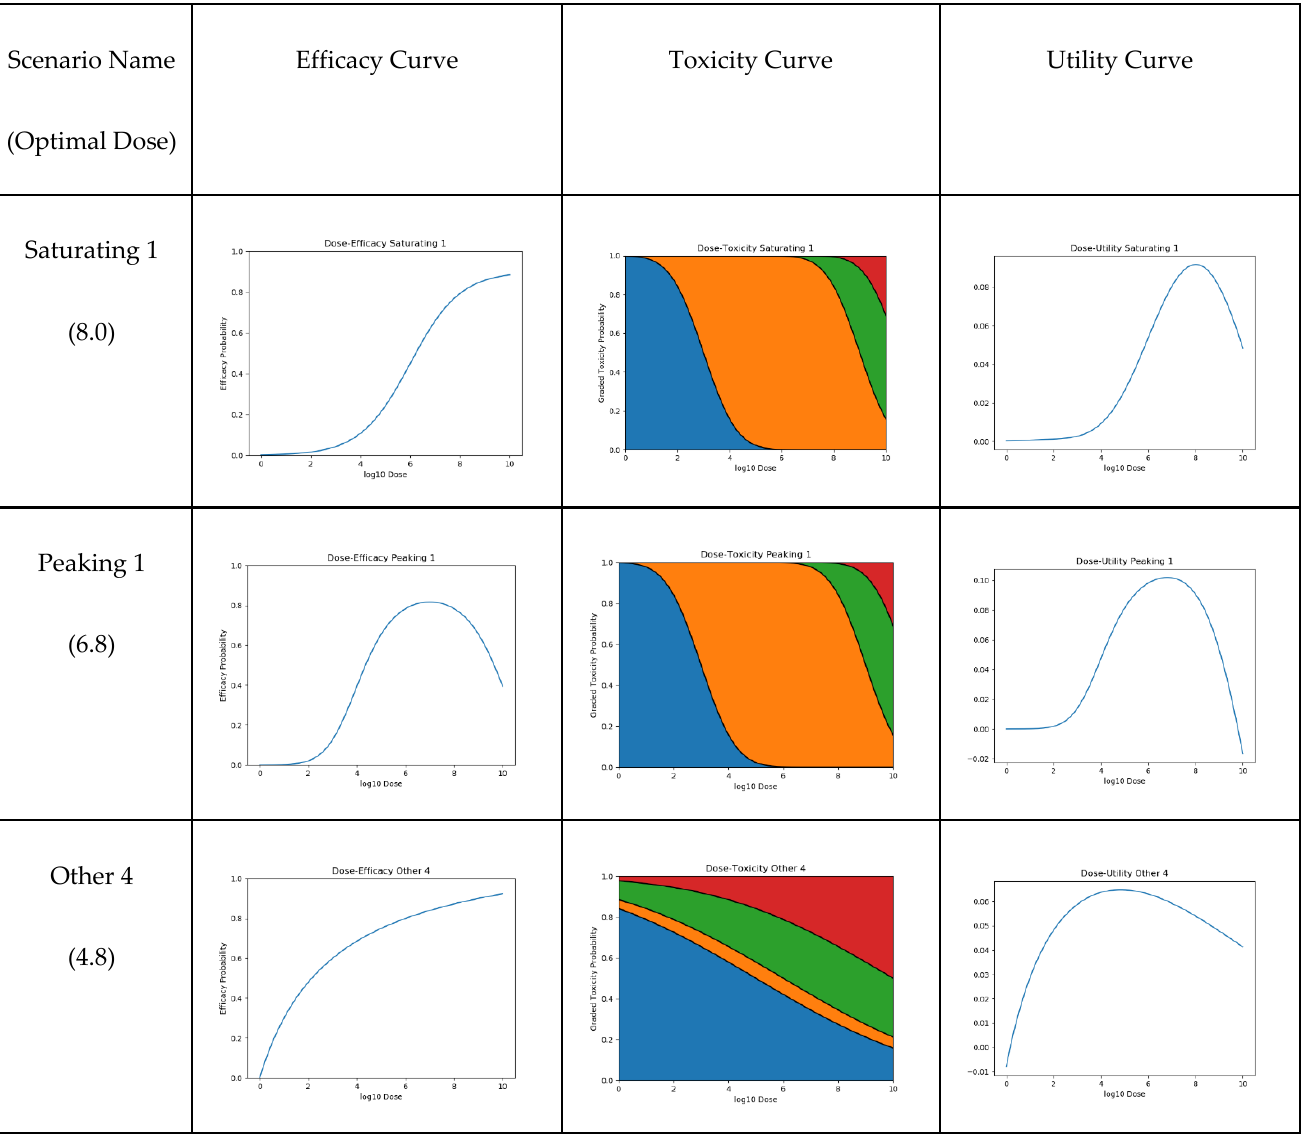
Figure 5. Three examples of the 14 tested scenarios. For each scenario, we show dose efficacy, dose toxicity, and the resultant dose–utility plots. Optimal dose is also given. For the toxicity plots, grade 0, 1, 2, and 3 adverse event probabilities are represented by blue, orange, green, and red, respec- tively.